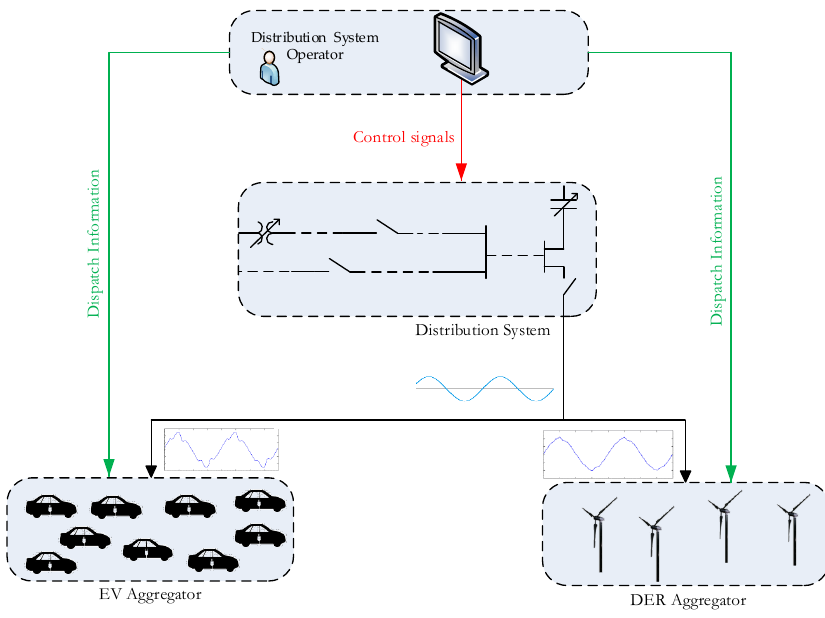
Figure 1. Conceptual diagram depicting cancellation of harmonic from electric vehicles (EVs) by wind generators (WGs) at distribution feeder level.